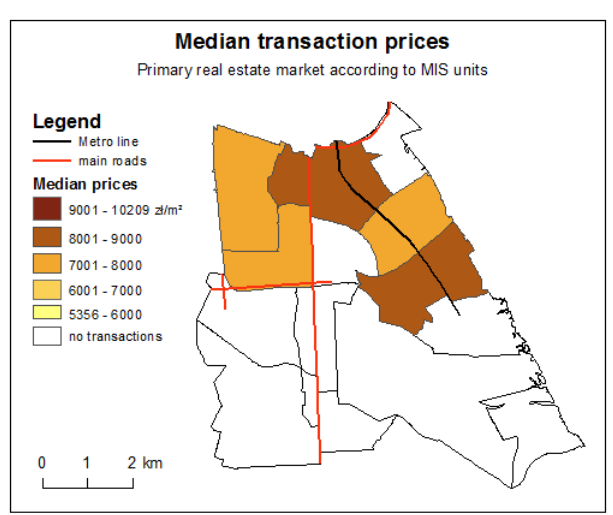
Fig. 7. Average prices of residential premises on the primary real estate market in Ursynów, according to MIS units